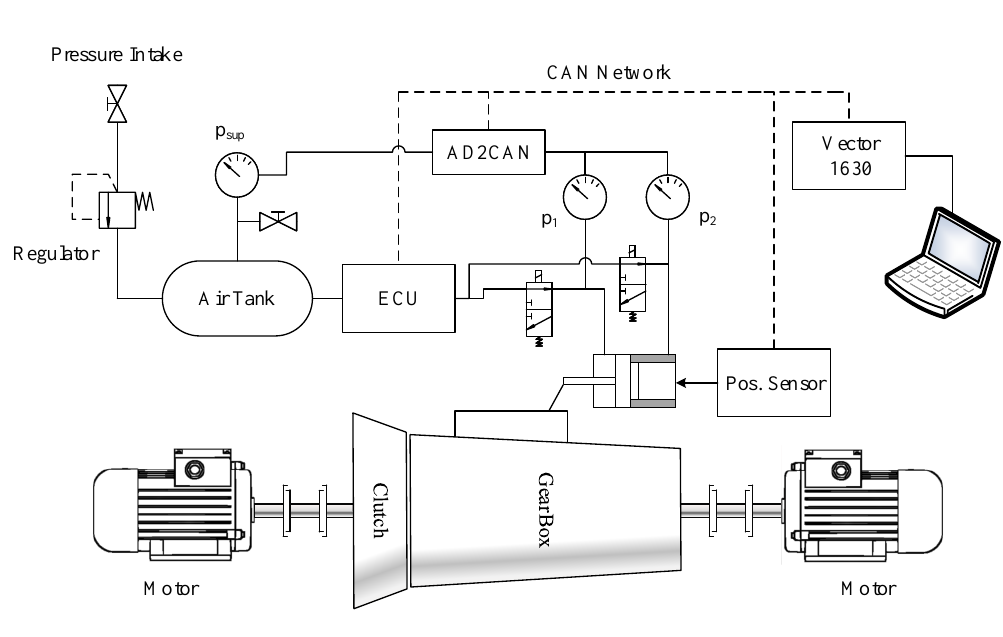
Figure 8. Measurement